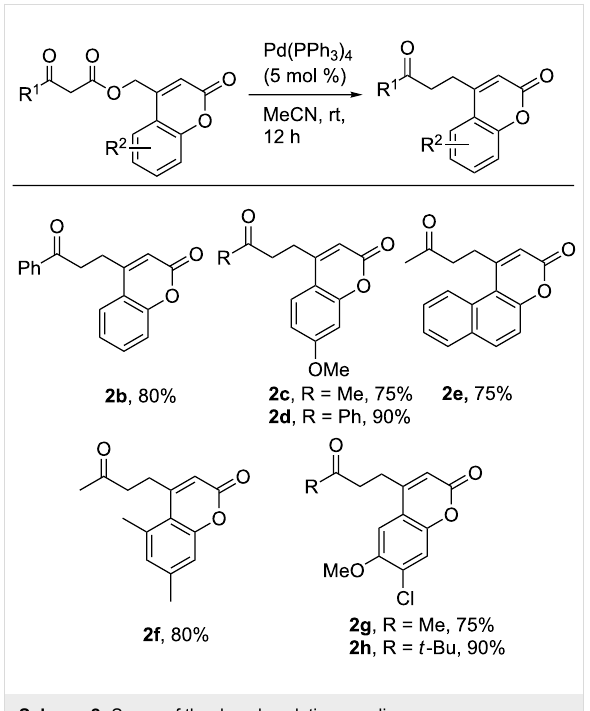
Scheme 2: Scope of the decarboxylative